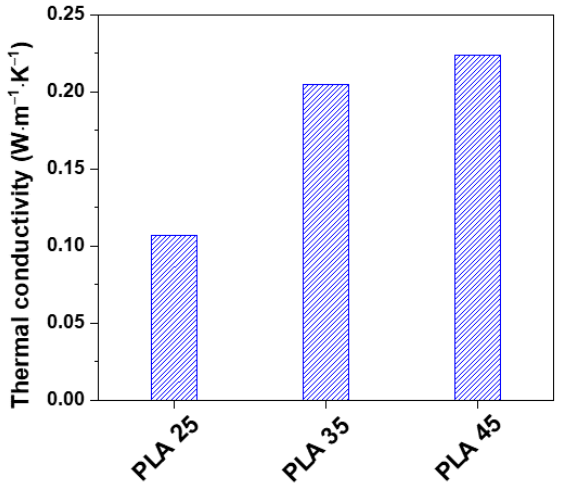
Figure 5. Thermal conductivities of the three electrospun/electrosprayed PEG/PLA films measured at 30 °C.